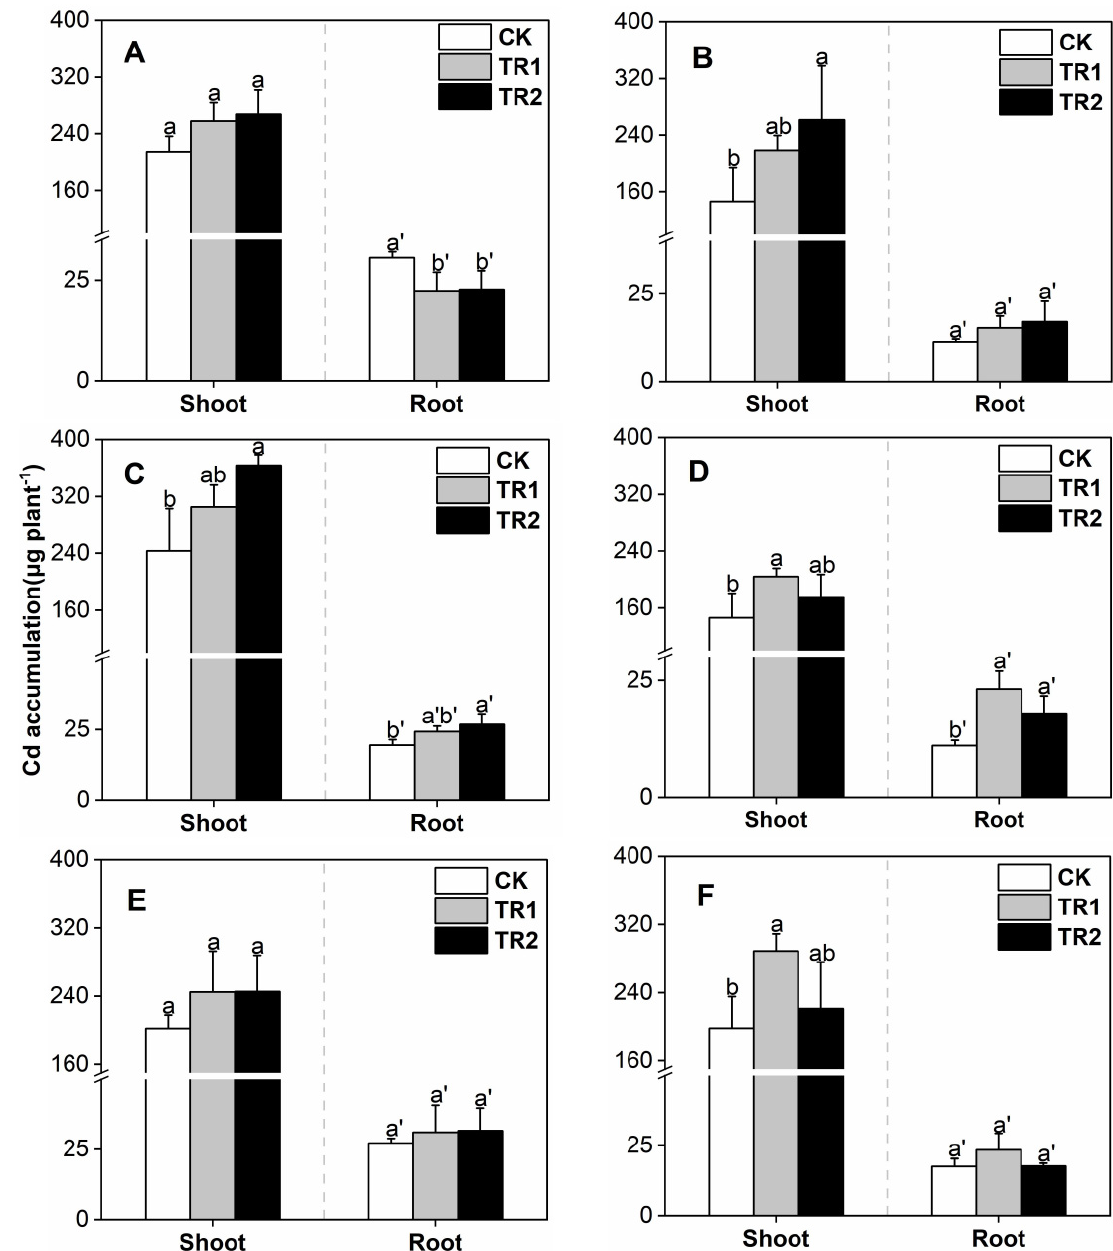
Figure 6. Oil sunflower Cd accumulation. ( A ) First period intercropping papaya, ( B ) Second period intercropping papaya, ( C ) First period intercropping grapefruit, ( D ) Second period intercropping grapefruit, ( E ) First period intercropping fig, ( F ) Second period intercropping fig. The different letters above the column indicate the significant differences among different treatments at p < 0.05.